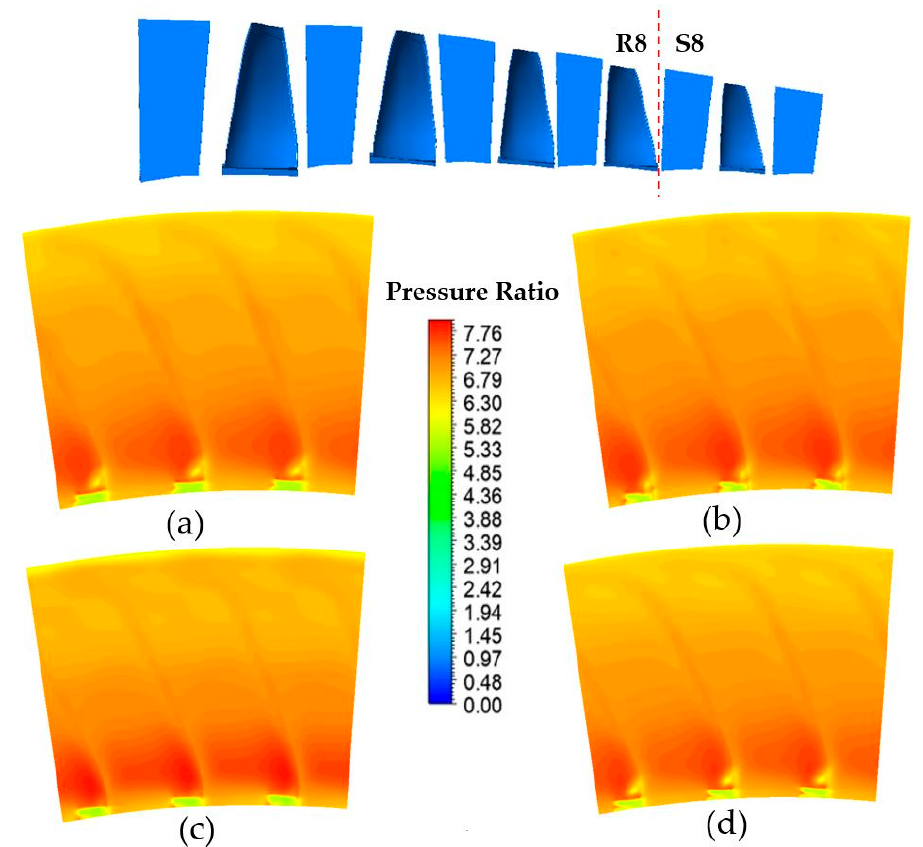
Figure 10. Pressure ratio between the middle plan of R8–S8 of the blade: ( a ) before modification, after modifications of ( b ) 1 mm, ( c ) 5 mm, and ( d ) 10 mm.